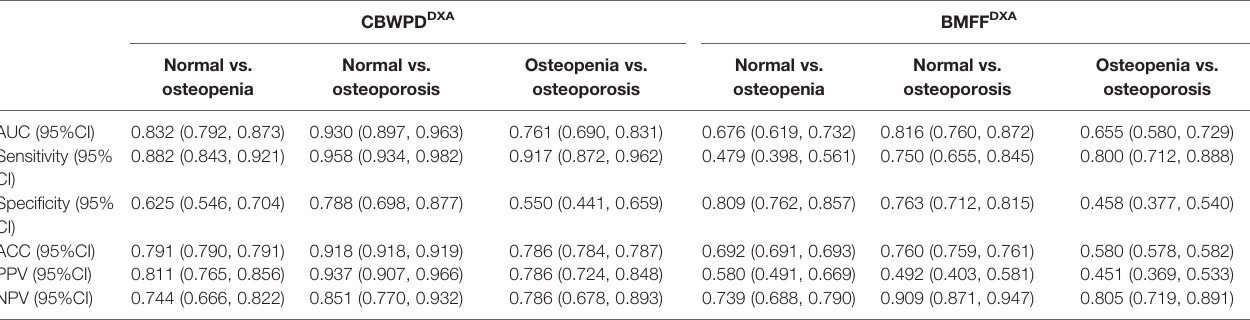
TABLE 3 | Performance of the CBWPD DXA and BMFF DXA in discrimination between three cohorts of normal subjects, patients with osteopenia, and patients with osteoporosis, with DXA as reference standard. CBWPD DXA BMFF DXA Normal vs. Normal vs. Osteopenia vs. Normal vs. Normal vs. Osteopenia vs. osteopenia osteoporosis osteoporosis osteopenia osteoporosis